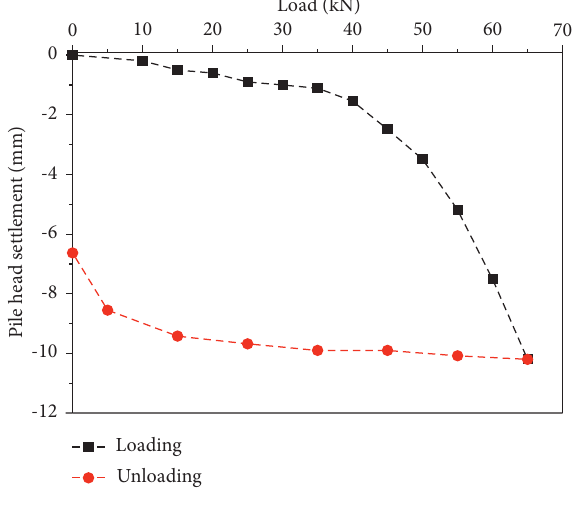
Figure 4: Pile load settlement